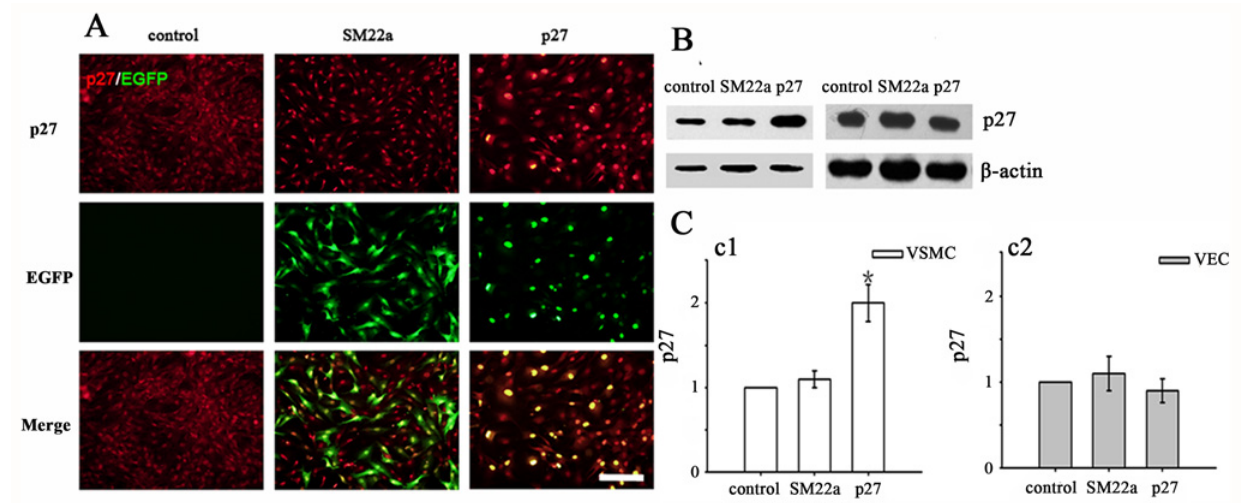
Fig 1. Vascular smooth muscle cells (VSMCs) overexpressed p27 under the control of the SM22alpha promoter in vitro. A. Immunofluorescence double staining of cells in the control, SM22a and p27 VSMC groups. P27 stained red while EGFP stained green. The images represent nuclear overexpression of p27 and EGFP in the p27 control group and SM22a group. Scale bar: 100 μ m. B. Western blot analysis to evaluate p27 expression in VSMCs (b1) and VECs (b2). C. Western blot analysis of p27 content in VSMCs (c1) and VECs (c2). * The p27 content of Lenti-SM22alpha-p27 infected VSMCs was higher compared to control and SM22a groups. Error bars represent the mean ± S.E. (n =